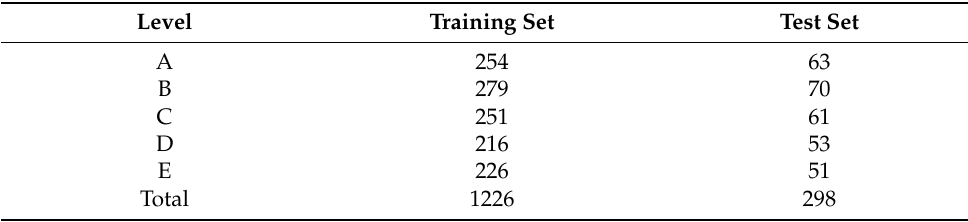
Table 1. Sample assignment of training and test